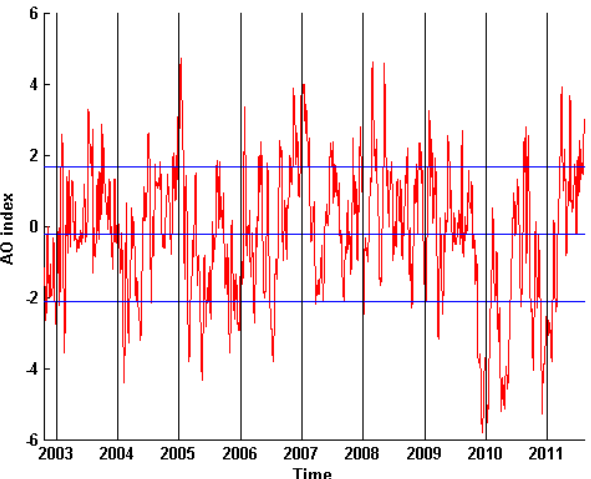
Fig. 1. The daily AO index for the months of NDJFM each year from December 2002 till March 2011. The blue line in the center Fig. 1: The daily AO index for the months of NDJFM each year from Dec 2002 till is mean AO index for the chosen time period, while other two blue March 2011.The blue line in the center is mean AO index for the chosen time period, lines above and below indicate one standard deviation. while other two blue lines above and below indicate one standard deviation.